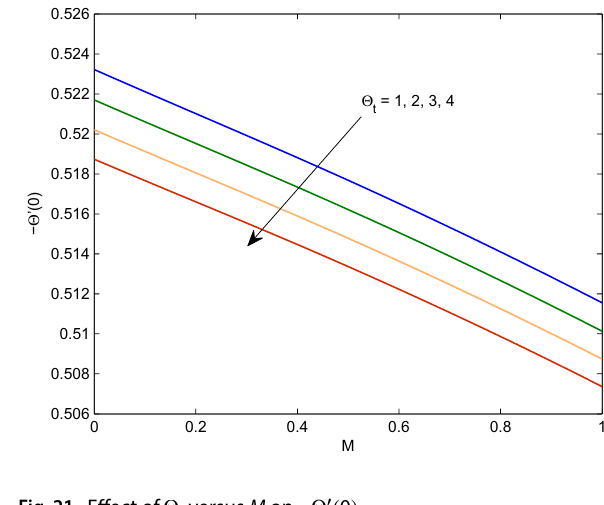
Fig. 21 Effect of Θ t versus M on −Θ � ( 0